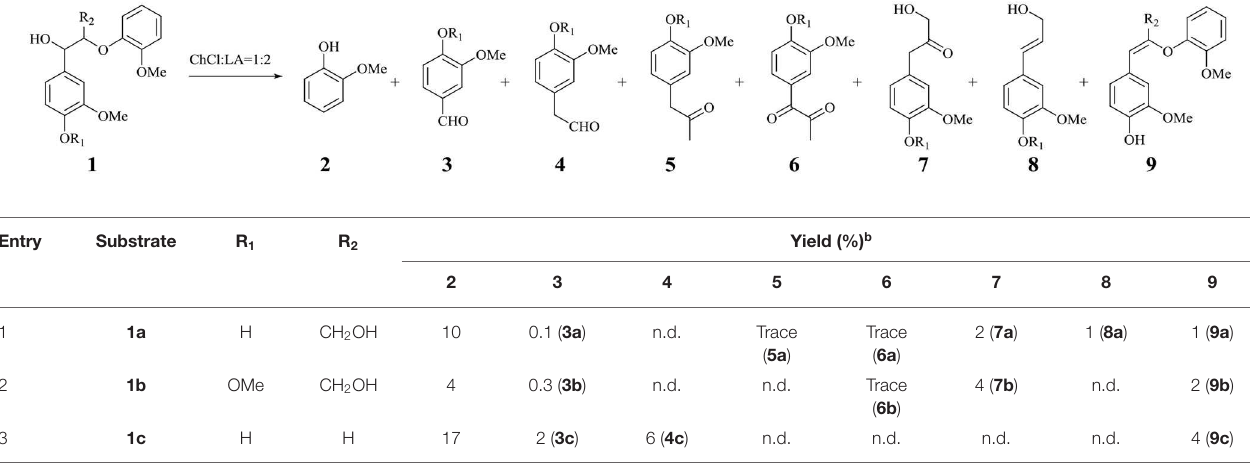
TABLE 2 | Product distribution of lignin β -O-4 dimeric compounds treatment with DES (ChCl/LA) a